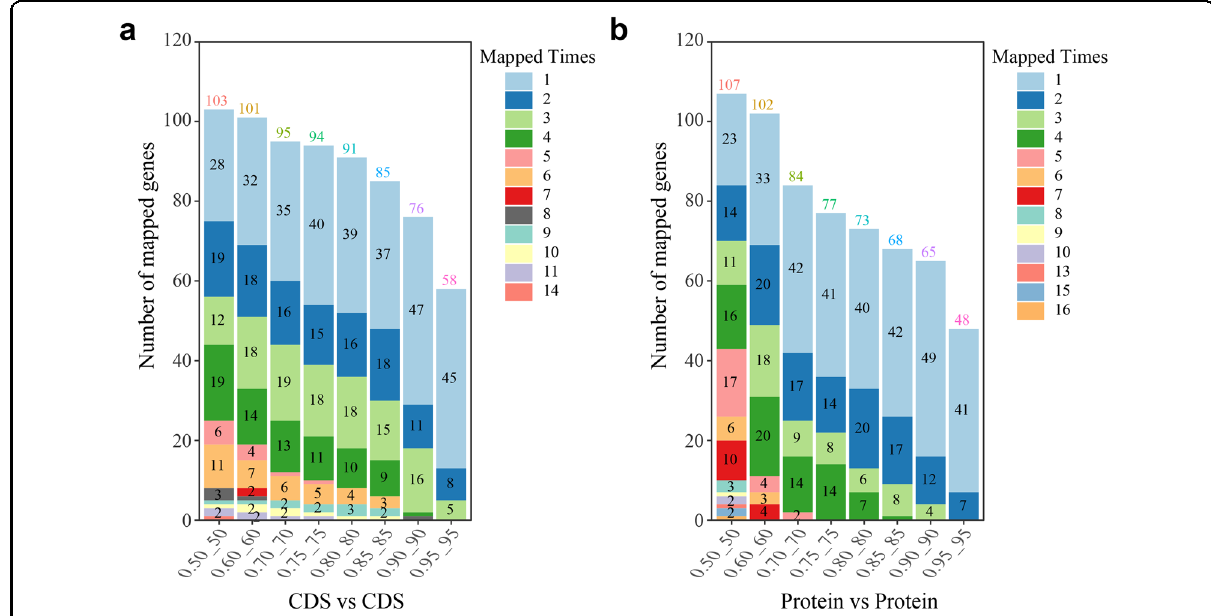
Fig. 2 Sequence alignments of conopeptides from one representative C. betulinus sample. We used the coding DNA sequences of conopeptide genes ( a ) and relevant protein sequences ( b ) to compare their similarity. The x -axis represents the alignment rate and the identity score of each alignment. For instance, 0.50_50 means the alignment rate is 0.50 and the identity score of this alignment is 50. “ Mapped Times ” represents the mapped number of single CDS/protein against the reference dataset. The number above each stacked bar stands for the total number of CDS/ protein that exists in the relevant reference dataset. The number within each bar represents the gene number with “ Mapped Times ” . Note that the gene numbers at 1 were not denoted in the fi